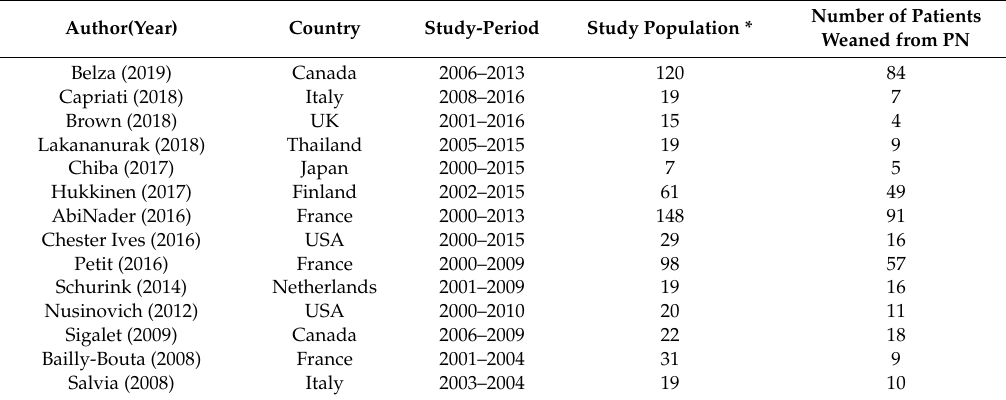
Table 1. Overview of the studies including patients treated with PN